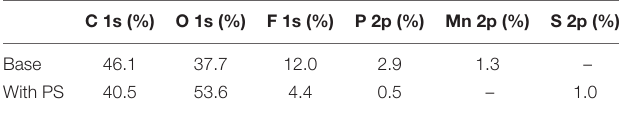
TABLE 3 | Element concentrations of the cycled anodes using base electrolyte and PS-containing